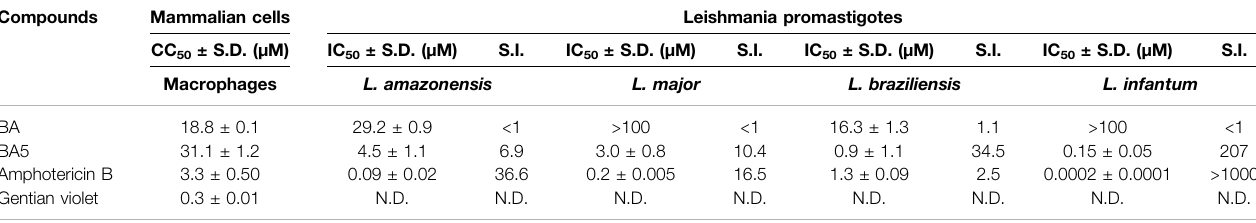
TABLE 1 | Cytotoxicity evaluation and antileishmanial activity against promastigotes of L. amazonensis, L. major, L. braziliensis, and L. infantum .